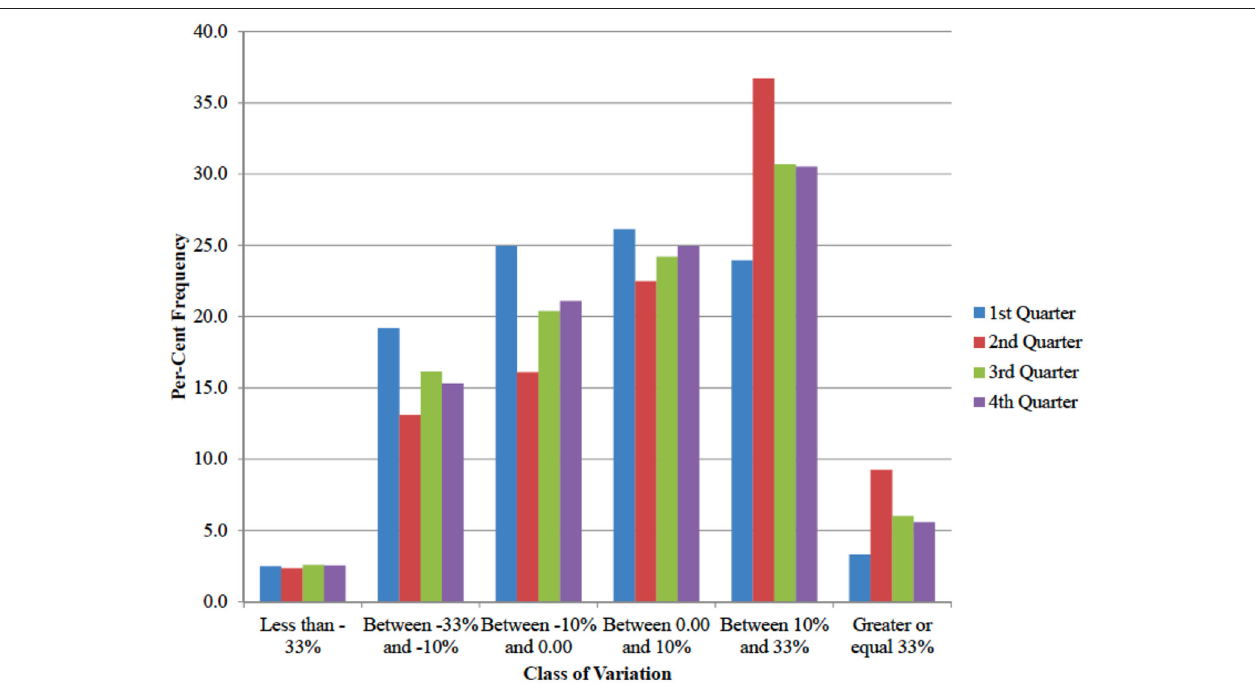
FIGURE 7 | Distribution of households by class of per-cent change in household expenditure for fruit and vegetables (per-cent frequencies, quarters 2020 compared to same quarter in 2019).